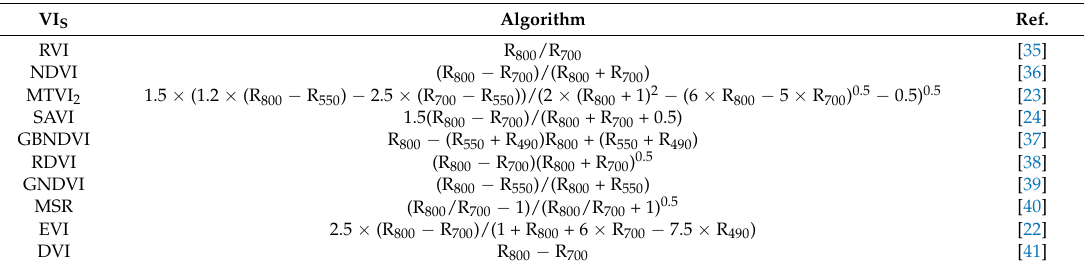
Table 3. Algorithms and references of all the possible VI S